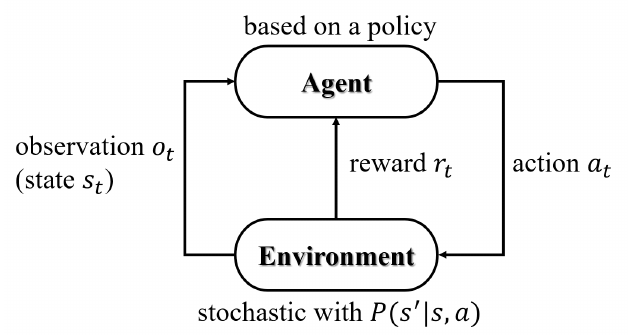
Figure 1. Markov Decision Process